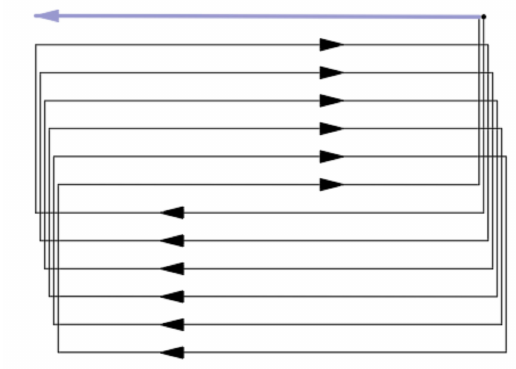
Figure 12. The final circling-forward